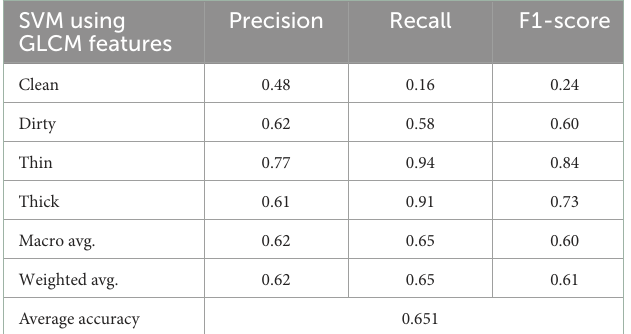
TABLE 3 Results of SVM using GLCM features.